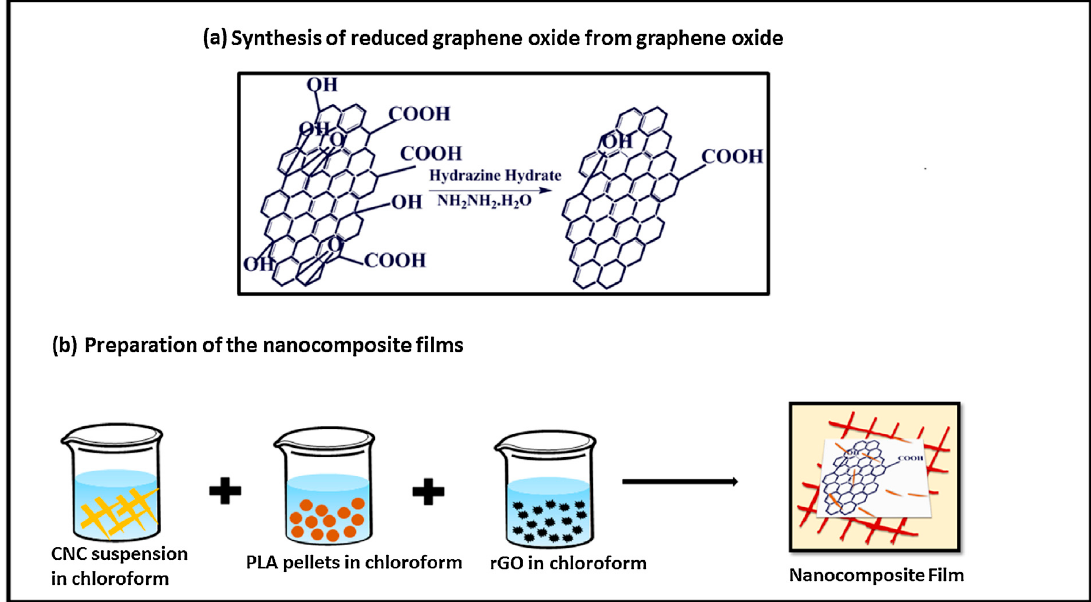
Figure 17. Schematic illustration of ( a ) the synthesis of reduced graphene oxide (RGO) from GO, ( b ) the method employed to prepare nanocomposite films. Reproduced with permission from Reference [185]. Copyright ©2017, Elsevier.